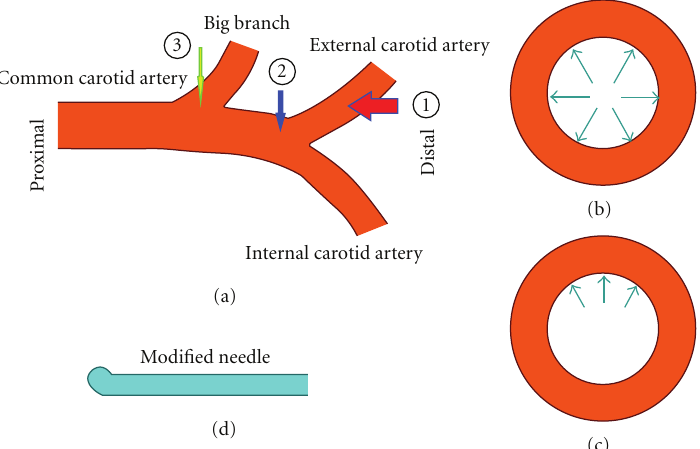
Figure 1: Procedure of OCT imaging and injury (schematic). (a) The imaging catheter and injury-causing device are advanced initially to the common carotid artery through the external carotid branch (arrow (1)). At the end of the study, the imaging catheter is again advanced to the common carotid artery through the region between the old incision and the big branch (arrow (2) or arrow (3)). (b) Balloon injury results in endothelial denudation with the formation of concentric lesions (arrows indicate the sites of endothelial denudation). (c) A modified metal needle generates an endothelial injury with the formation of eccentric lesions (arrows indicate the sites of endothelial denudation). (d) A modified metal needle with a blunt and rounded front head and diameter of 0.0285 inches was